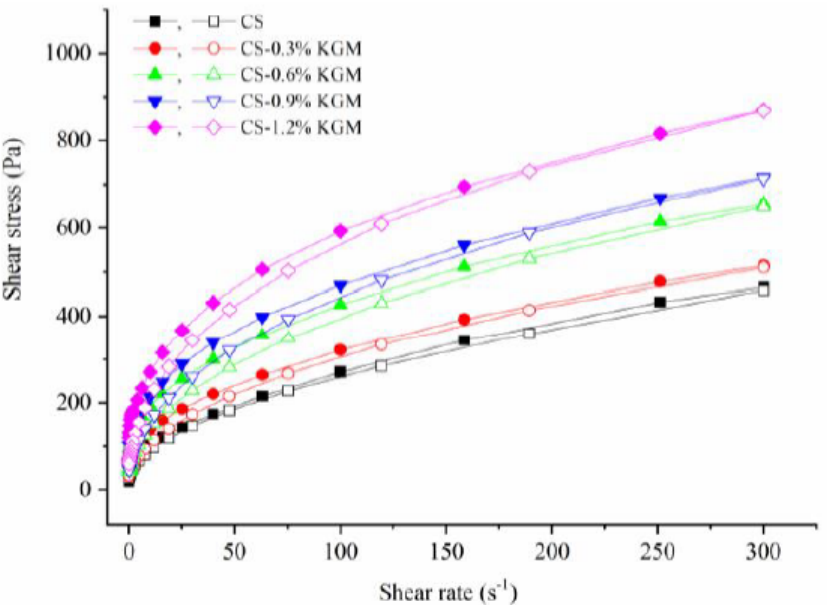
Figure 1. Flow curves of CS/KGM mixtures. Closed symbols denote the upward line and opened symbols denote the downward